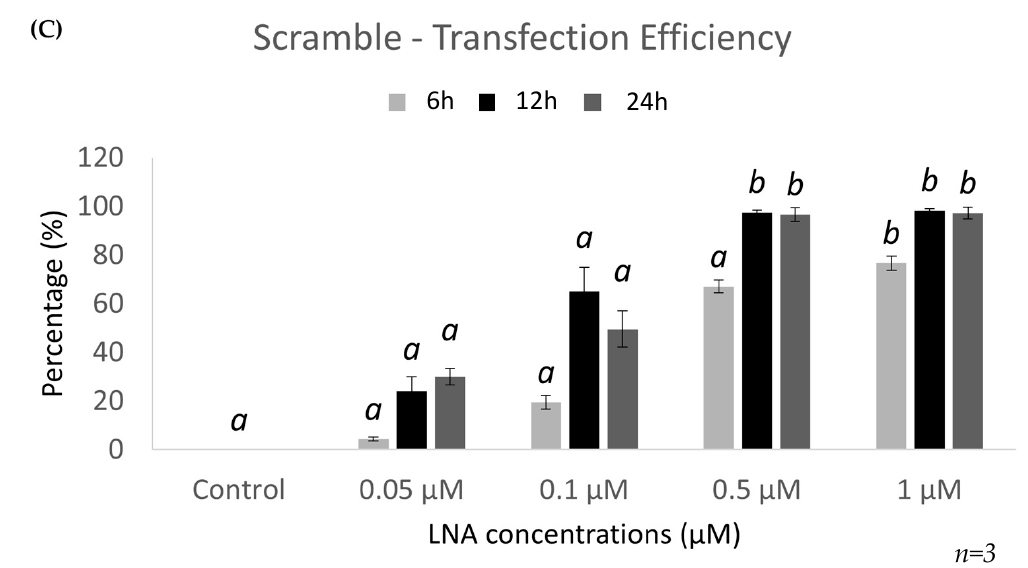
Figure 3. Flow Cytometry of LNAs at different concentrations . Transfections with FAM-labeled LNA probes at 0.05 µ M, 0.1 µ M, 0.5 µ M, and 1 µ M for 6, 12, and 24 h. ( A ) depicts a representation of flow cytometry scatter plots measured at 12 h post transfection. In vitro cultured granulosa cells were transfected, trypsinized, counterstained with Hoescht stain, and run through a BD Accuri C6 Flow Cytometer. Transfection efficiencies of the inhibitor ( B ) and the scramble ( C ) showed significantly increased transfection efficiencies at the higher concentrations (0.5 µ M and1 µ M). Different letters indicate significant differences, with b indicating a significantly different mean than a at p < 0.05. Bars represent the mean ± SEM.